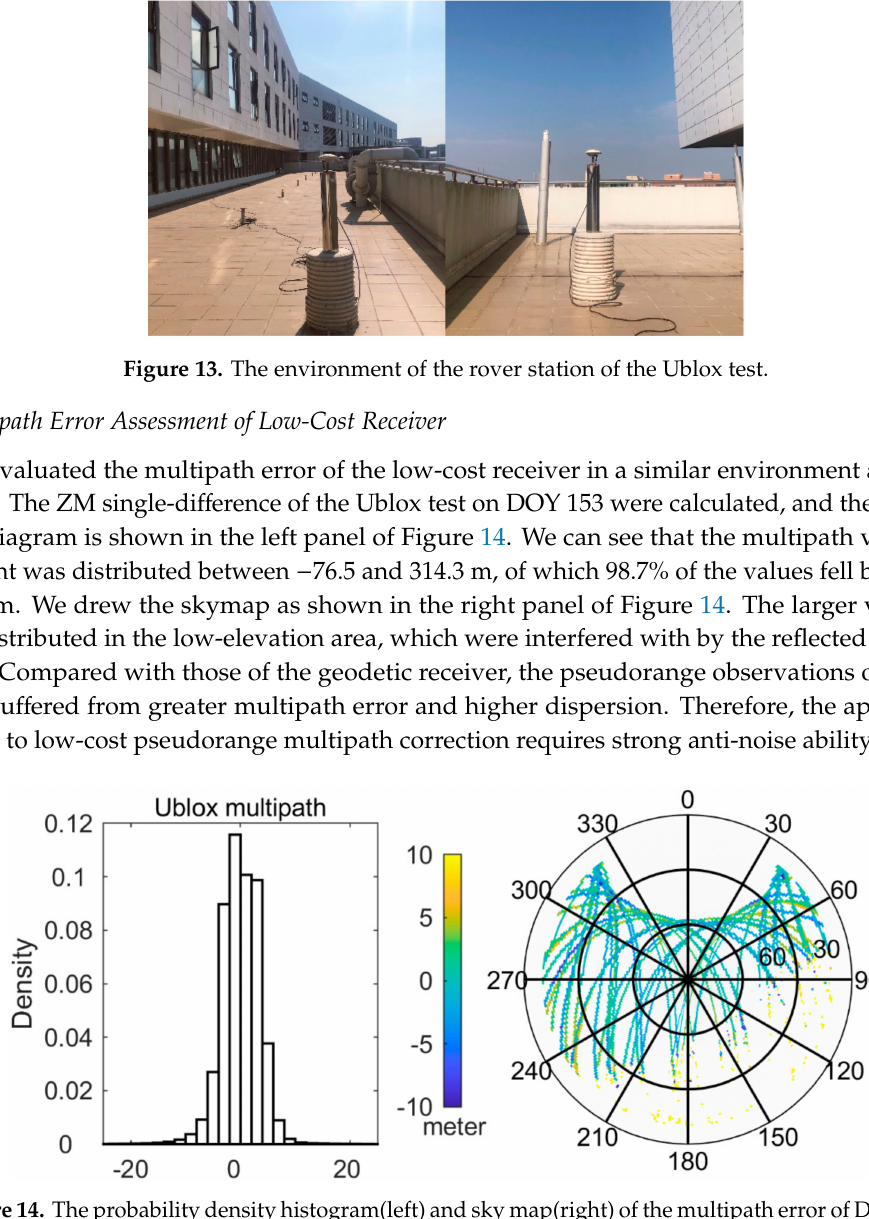
Figure 14. The probability density histogram(left) and sky map(right) of the multipath error of DOY